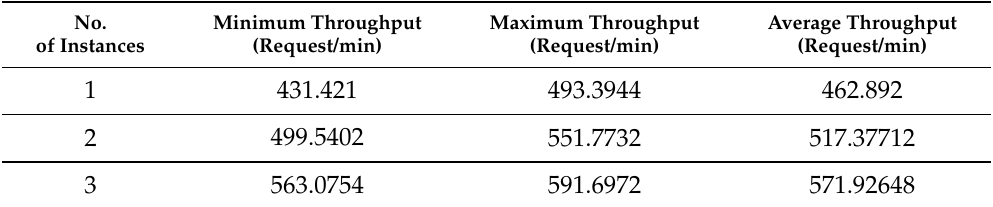
Table 2. (The results of Experiment 2.1): the number of handled concurrent requests over multiple deployed instances of SEMi core for one